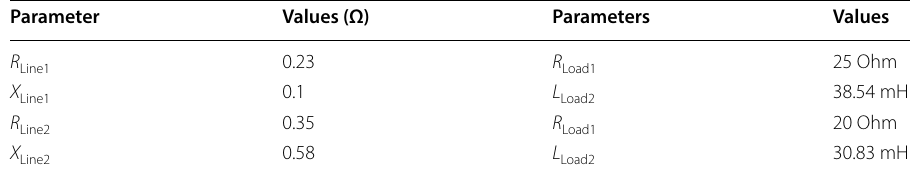
Table 3 Network and load parameters